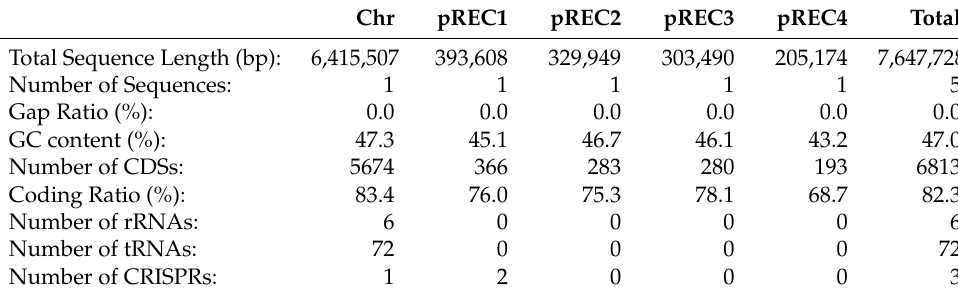
Figure 2. Genome structure of A . marina MBIC10699. The different rings represent, from outside to inside, all CDS (counterclockwise: blue, clockwise: green), deviation from the average GC content, GC skew, and CDS with colors corresponding to COG categories. For visualization, all plasmids are represented on a 10-fold scale relative to the chromosome. Table 1. General features of the genome of A . marina